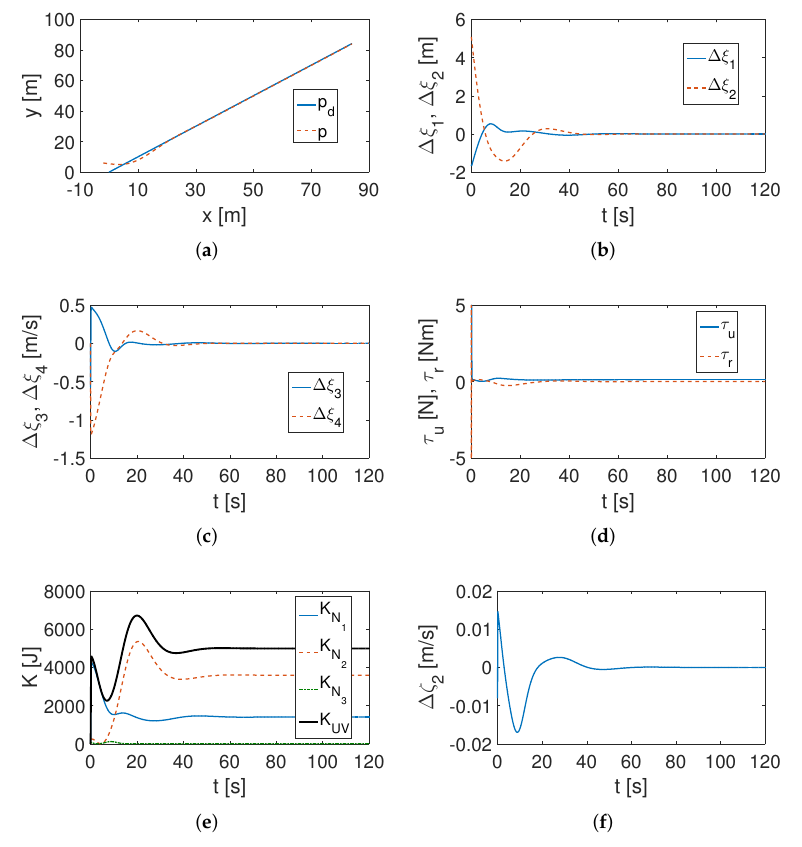
Figure 2. Simulation results for ROPOS QV controller and linear trajectory: ( a ) desired and realized trajectory; ( b ) position error states; ( c ) velocity error states; ( d ) applied force and torque; ( e ) kinetic energy time history; and ( f ) error ∆ ζ 2 .